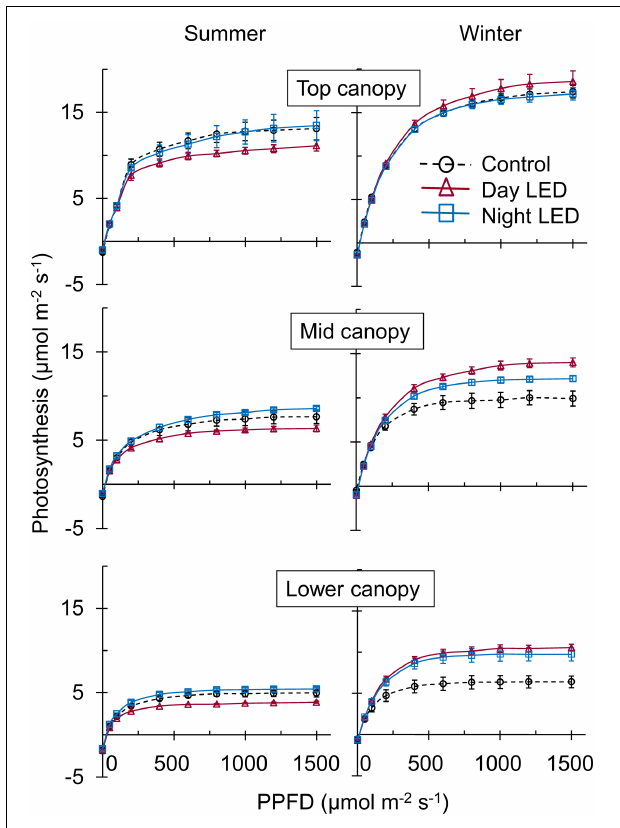
FIGURE 2 | Effect of LED inter-lighting on single-truss tomato leaf photosynthetic capacity. Measurements were taken in representative leaves from each canopy section (top, middle, and lower) of control and LED inter-lighted plants. We measured the light–response curve of the photosynthetic rate, from 10:00 am to 2:00 pm under growth condition. Data represent means ± SE ( n =